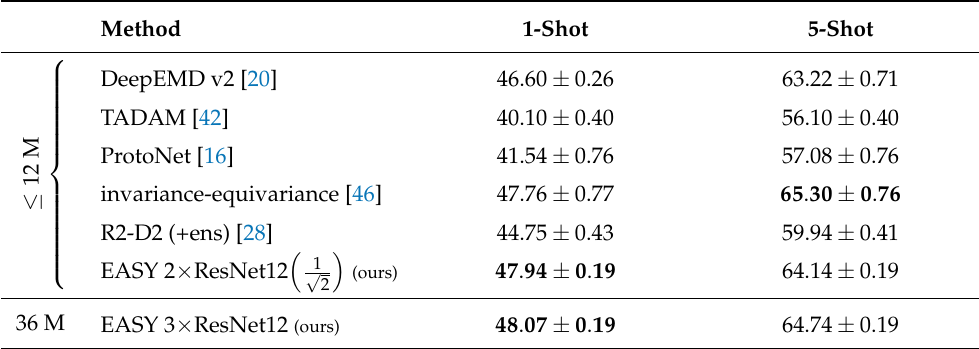
Table 5. The 1-shot and 5-shot accuracy of state-of-the-art methods and the proposed solution on FC-100 in the inductive setting.